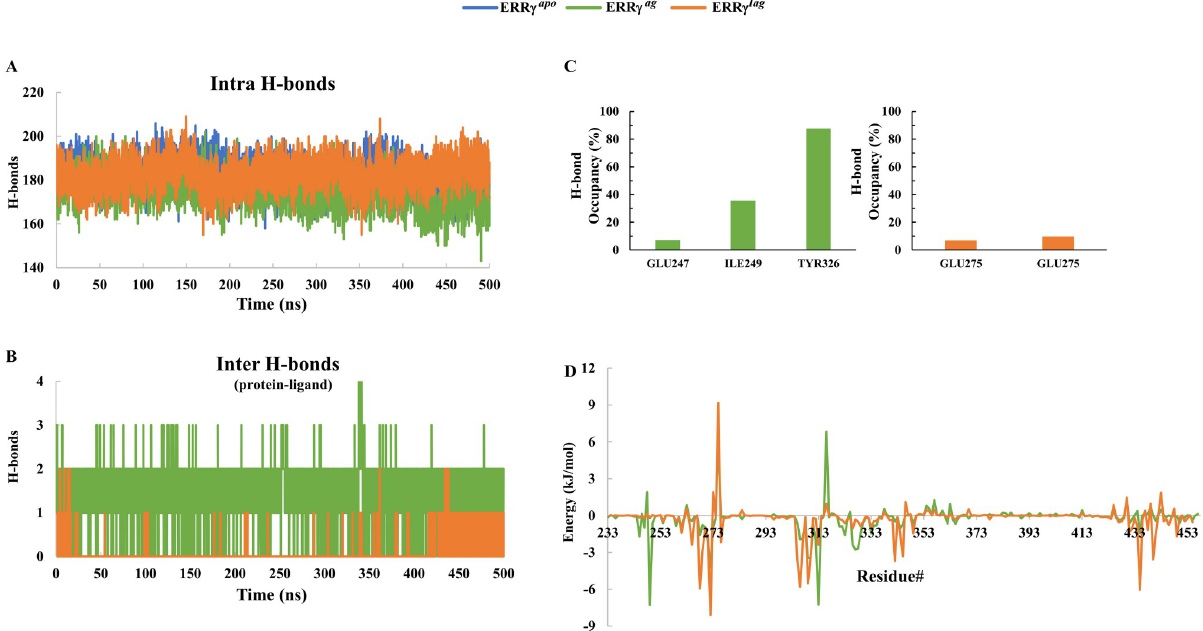
Fig 4. H-bond and free energy decomposition of ERR γ apo , ERR γ ag and ERR γ iag complex: (A) Number of intra H-bonds in ERR γ apo , ERR γ ag and ERR γ iag . (B) H-bonds formed between agonist/inverse agonist and ERR γ . (C) The percentage of H-bond occupancy between the key residues with the ligands. The two bars of E275 in ERR γ iag represent two atoms that act as either an acceptor or donor. (D) Energy decomposition of the residues in ERR γ ag and ERR γ iag .